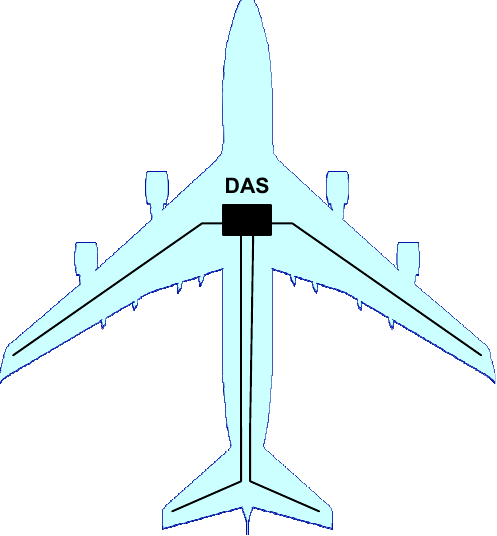
Figure 1. DAS system driving four fiber optic